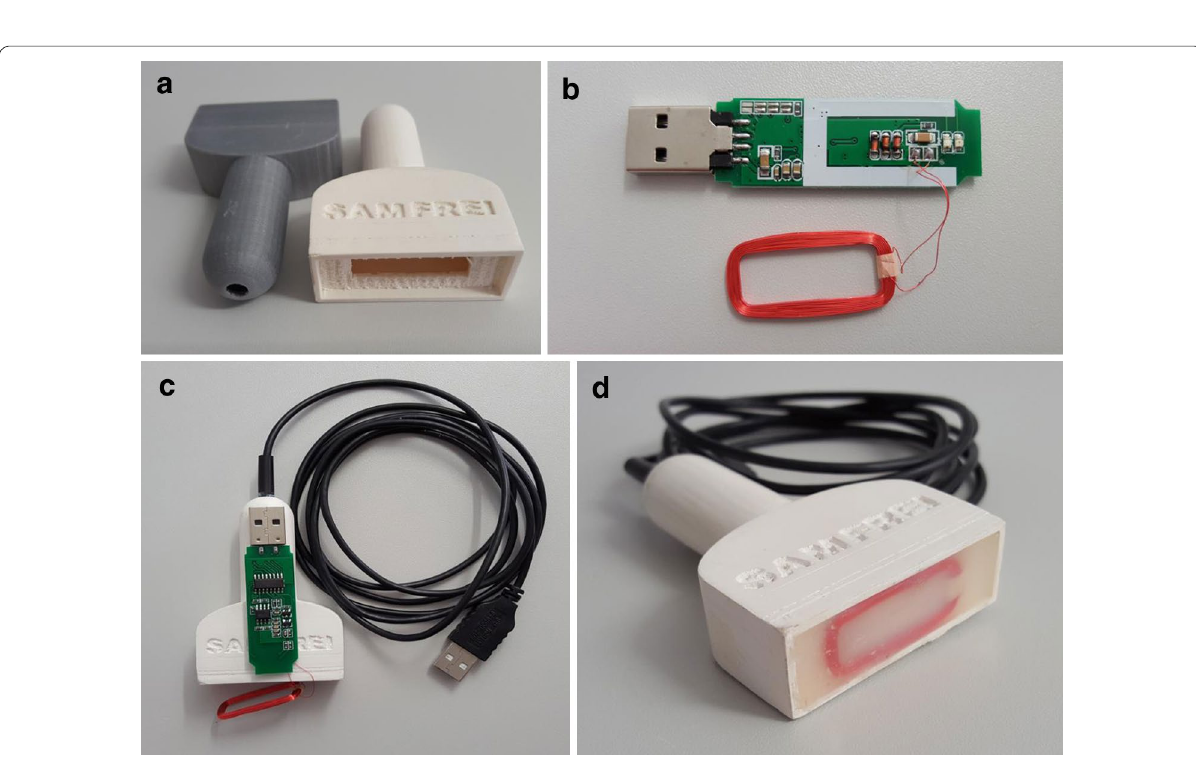
Fig. 2 Three-dimensional printed mock ultrasound probe with RFID antenna. a Raw material as printed. b The partly disassembled RFID antenna, which originally has USB-stick format. c How the antenna is built into the housing. d The complete probe with USB